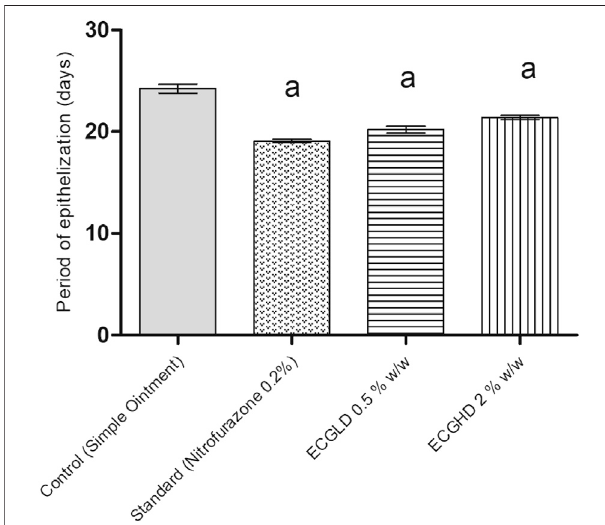
FIGURE 3 | Period of epithelization in excision wound model. ECPLD: extractof C.gigantea (L.)Dryandlowdose; ECPHD:extractof C.gigantea (L.) Dryand high dose; a (cid:2) P < 0.001 vs. control; b (cid:2) P < 0.01 vs. control; c (cid:2) p < 0.05 vs. control.